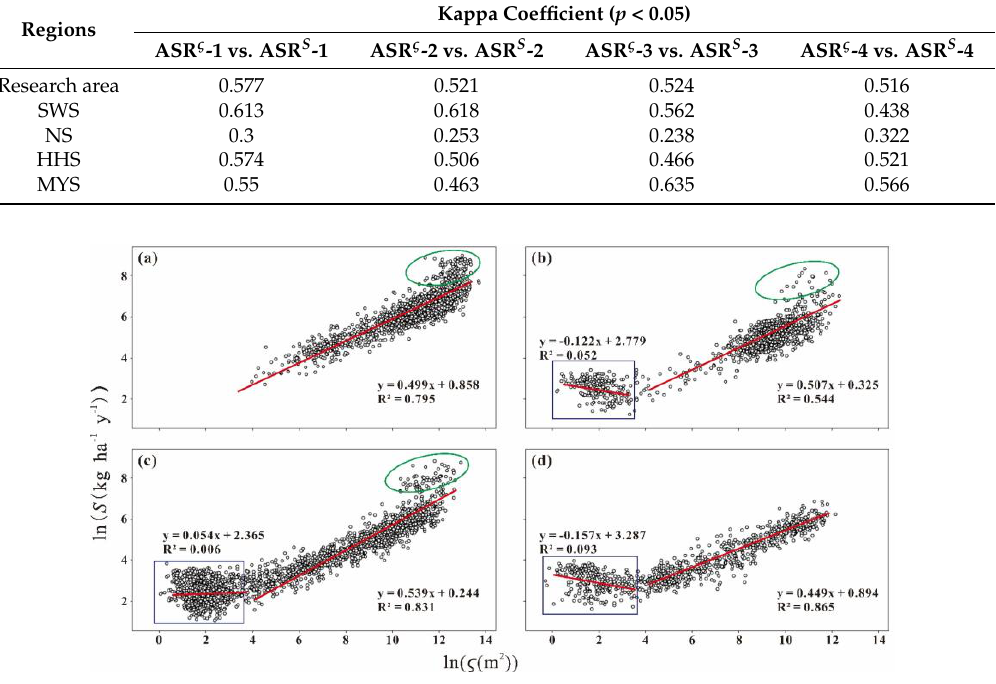
Figure 12. Fitting relationship between the scale effect index S and the sill value ς of the DEM semi-variogram in different sub-regions when the spatial resolution is 20 km: Southwest winter wheat sub-region (SWS) ( a ), north winter wheat sub-region (NS) ( b ), Huang-Huai winter wheat sub-region (HHS) ( c ), and middle-lower reaches of the Yangzi River winter wheat sub-region (MYS) ( d